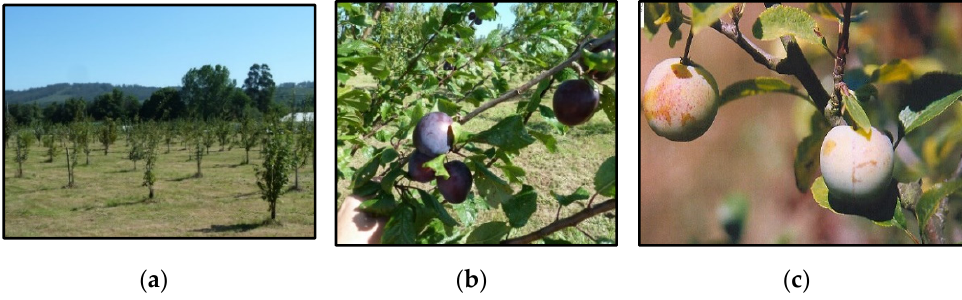
Figure 1. Plant material for establishment of plum cultures. ( a ) Orchard of the “Asociación Galega da Froita Autóctona do Eume”, ( b ) Collón de Frade Negro (CFN) genotype and ( c ) Claudia Blanca País (CBP) genotype.